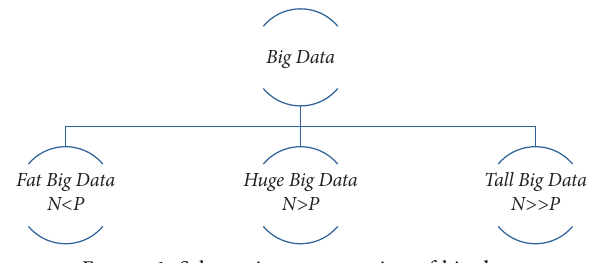
Figure 1: Schematic representation of big